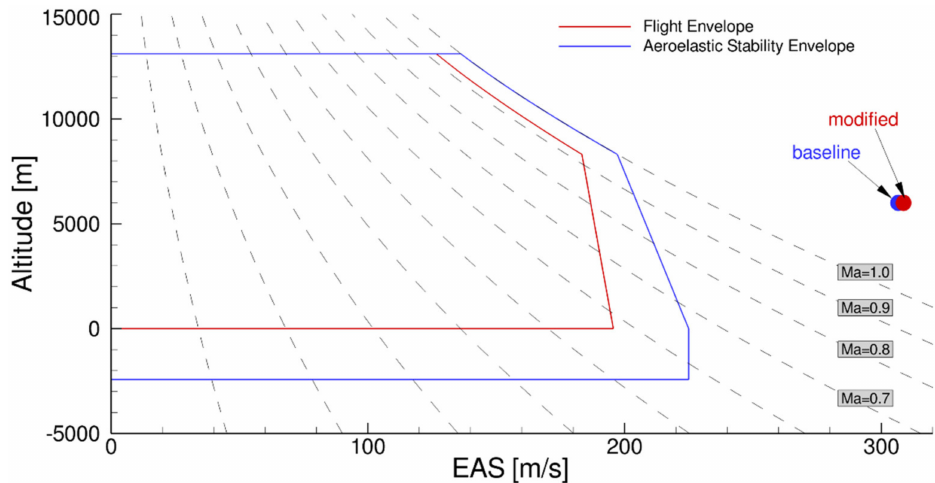
Figure 17. Aeroelastic stability envelope according to CS-25 §25.629 and the most critical flutter points of the two investigated aircraft